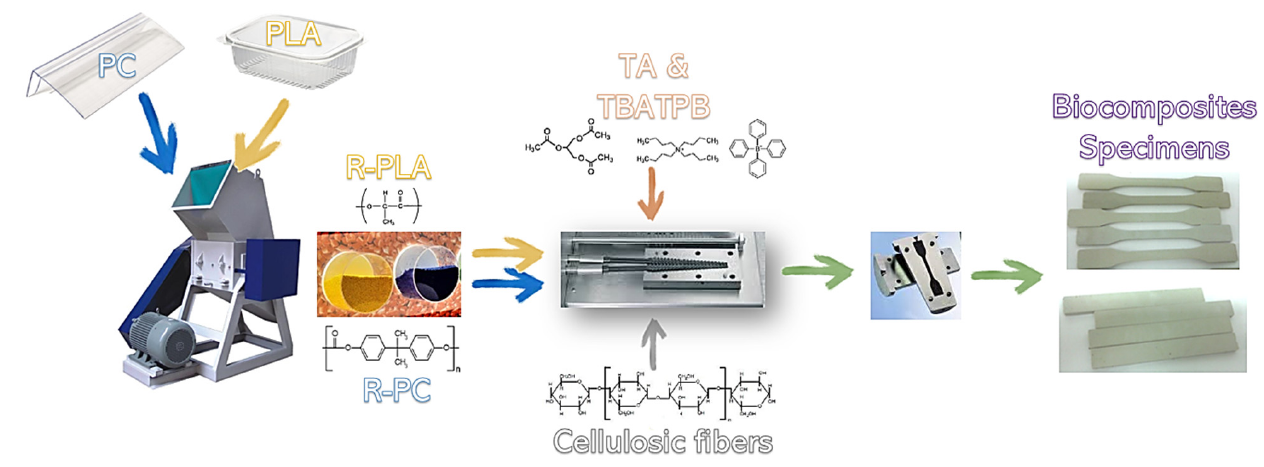
Figure 1. Processing route to obtain biocomposite samples.